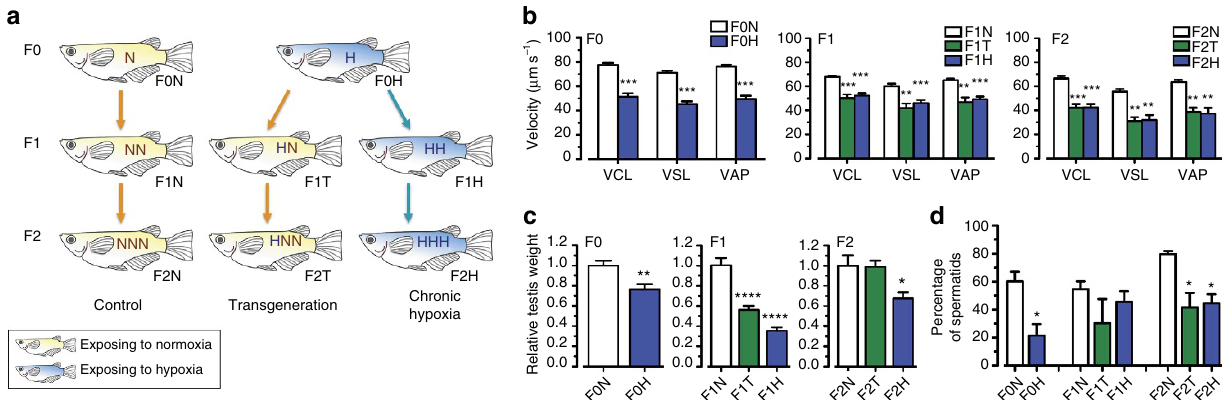
Figure 1 | Transgenerational reproductive impairment of the F0, F1 and F2 generations. ( a ) Experimental design. ( b ) Sperm motility in the F0, F1 and F2 generations. N, Tand H represent the normoxic, transgenerational and hypoxic groups, respectively. Asterisks denote statistical significance relative to the normoxic group ( n ¼ 8). VAP, average path velocity; VCL, curvilinear velocity; VSL, straight line velocity. ( c ) Effect of parental F0 hypoxic exposure on testis weight and ( d ) percentage of spermatids ( n ¼ 30–55). Data are presented as the means ± s.e.m. (* P o 0.05, ** P o 0.01, *** P o 0.001 and **** P o 0.0001).